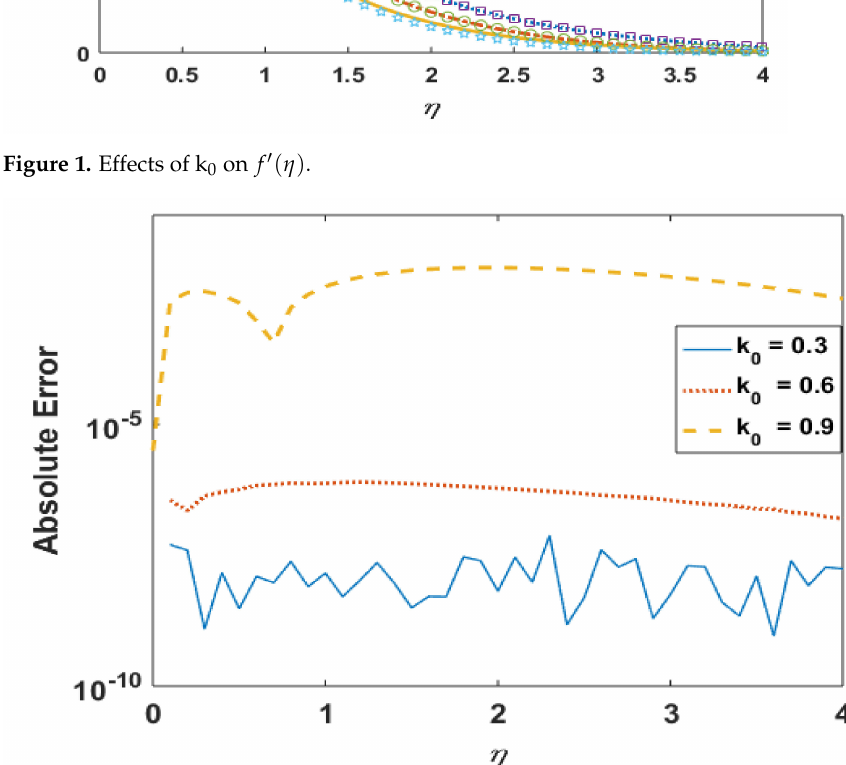
Figure 2. Absolute error in f (cid:48) ( η ) for different k 0 . Figure 7 portrays the effects of shear-thinning/thickening parameter “n” on the velocity profile f (cid:48) . The case (n < 1.0) represents the reduction in viscosity with the shear rate or shear-thinning effects, whereas the case (n > 1.0) shows the increase in viscosity with the shear rate or shear-thickening effect. The plot elucidates that the velocity field f